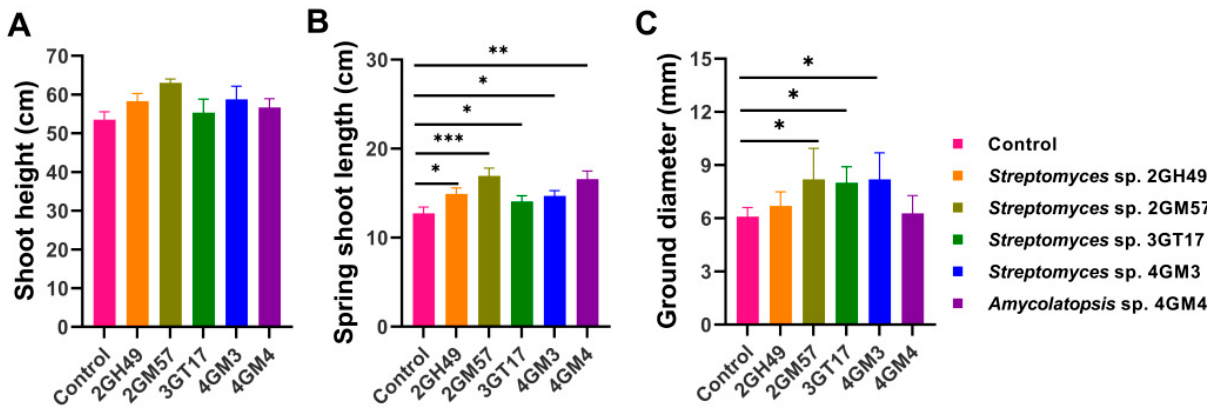
Figure 5. Effects of endophytic actinobacteria on the growth of C. oleifera seedlings under glasshouse conditions. ( A ): shoot height; ( B ): Spring shoot length; ( C ): ground diameter. Data are represented as the mean ± SE ( n = 10). Statistical comparisons with the control were made by ANOVA (* p < 0.05, ** p < 0.01, *** p < 0.005).